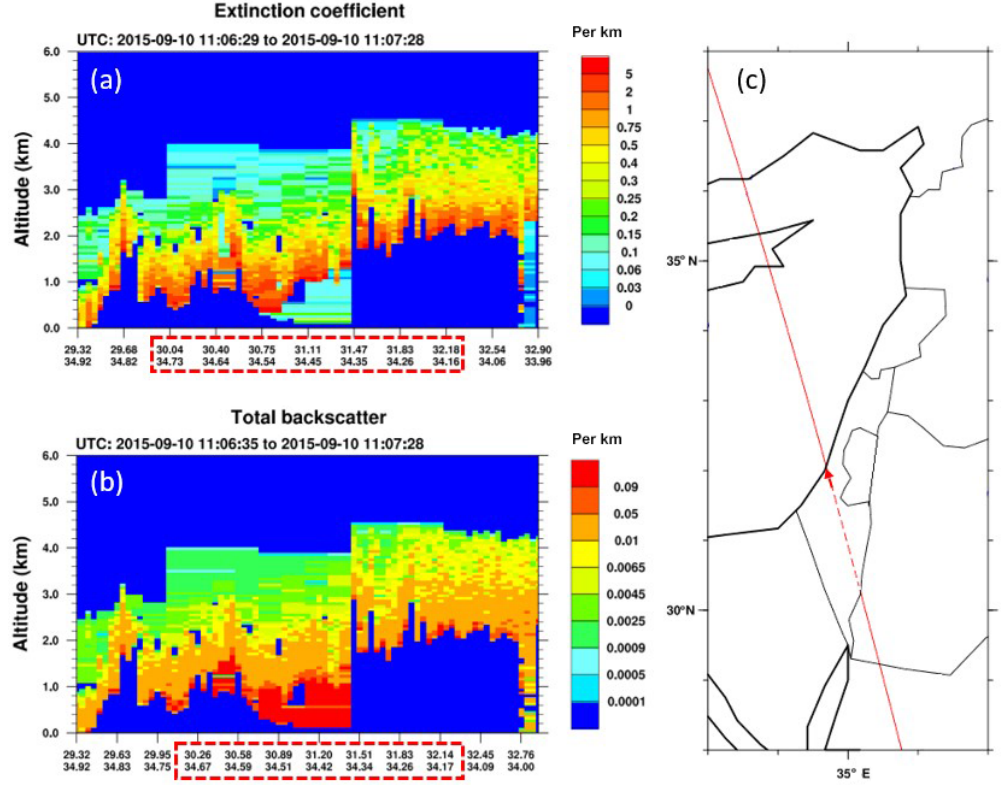
Figure 21. (c) A map of the EM centered on Israel with indication of CALIPSO satellite overpass from southeast to northwest (red line) on 10 September 2015 at 11:00–11:10UTC. CALIOP lidar products (from 532nm wavelength) of the extinction coefficient (a) and total backscatter (b) are given along the path over Israel (dashed red line). The ground elevation begins from − 20ma.s.l. at the southeastern point. A quarter of the way through, the ground level rises up to ∼ 600ma.s.l. and then gradually declines to sea level height as it reaches the shoreline in the northwestern